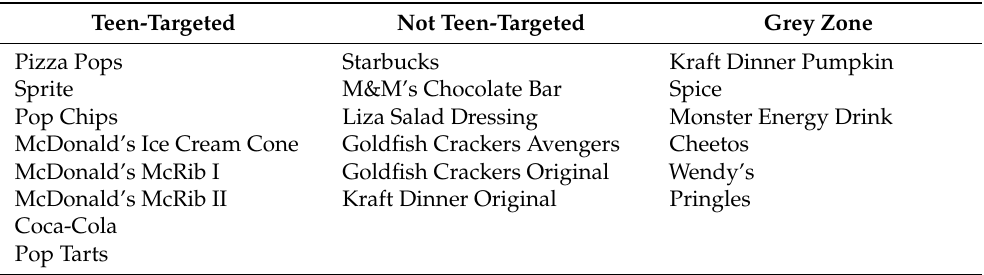
Table 2. Examples of food marketing used in the study (based on presence of teen-targeted indicators in the content, as defined by the